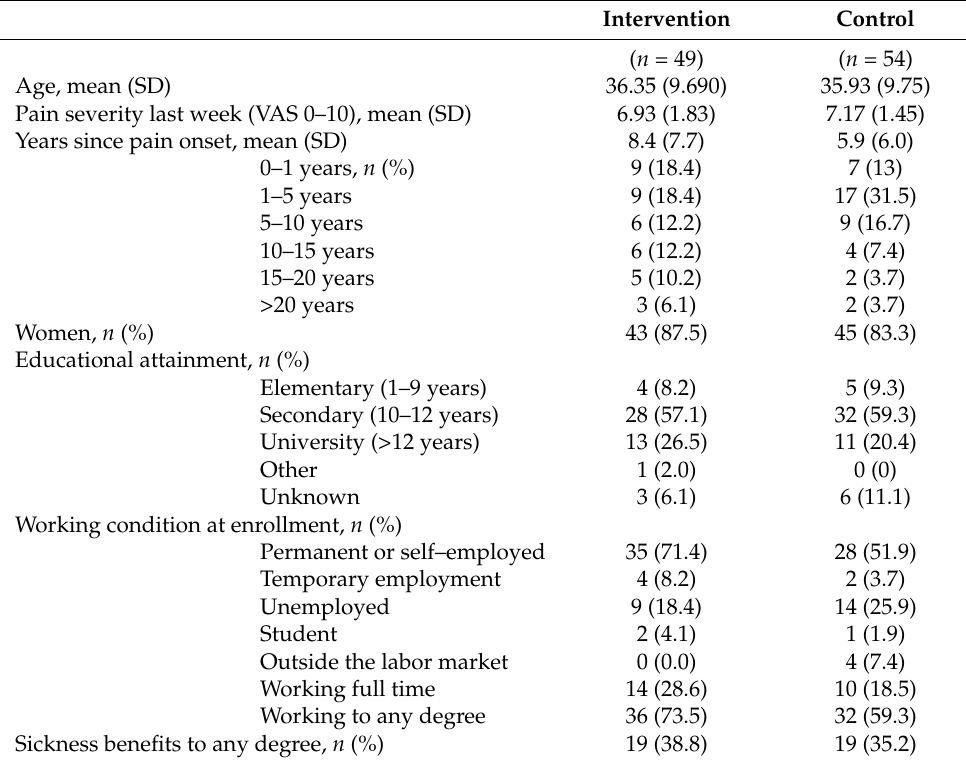
Table 1. Participants’ characteristics at